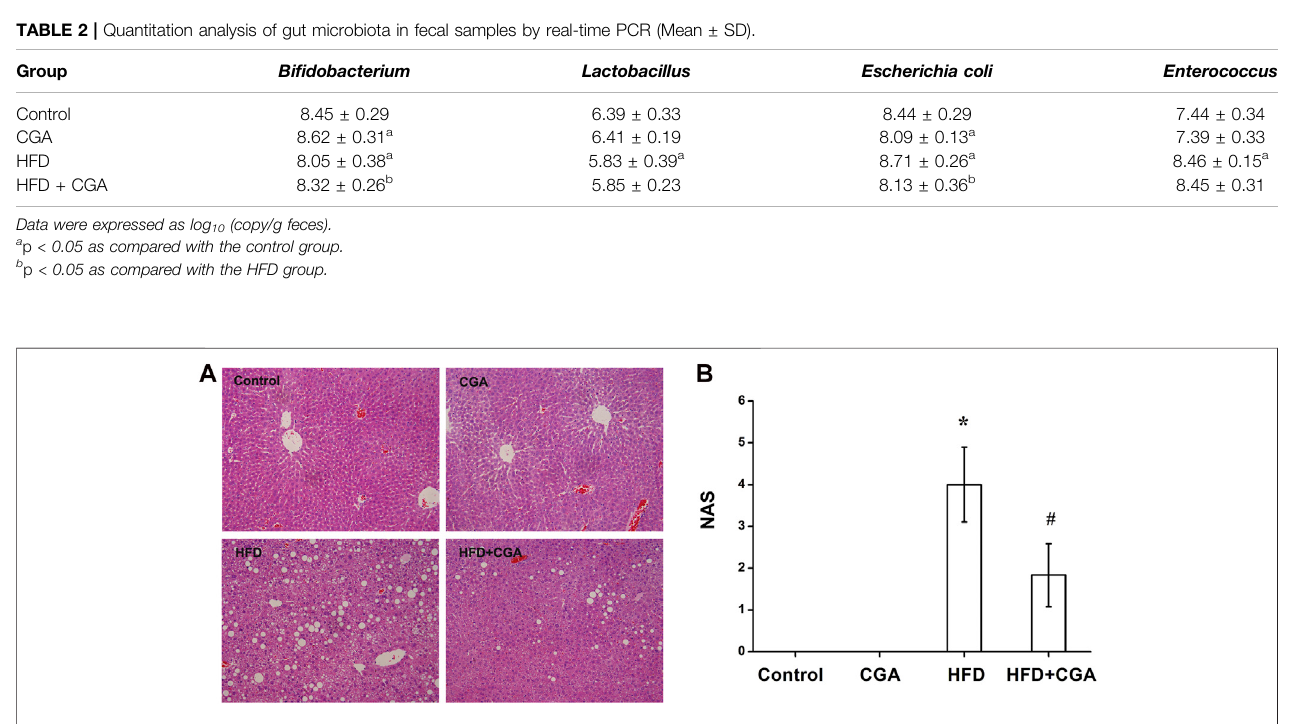
Frontiers in Pharmacology |